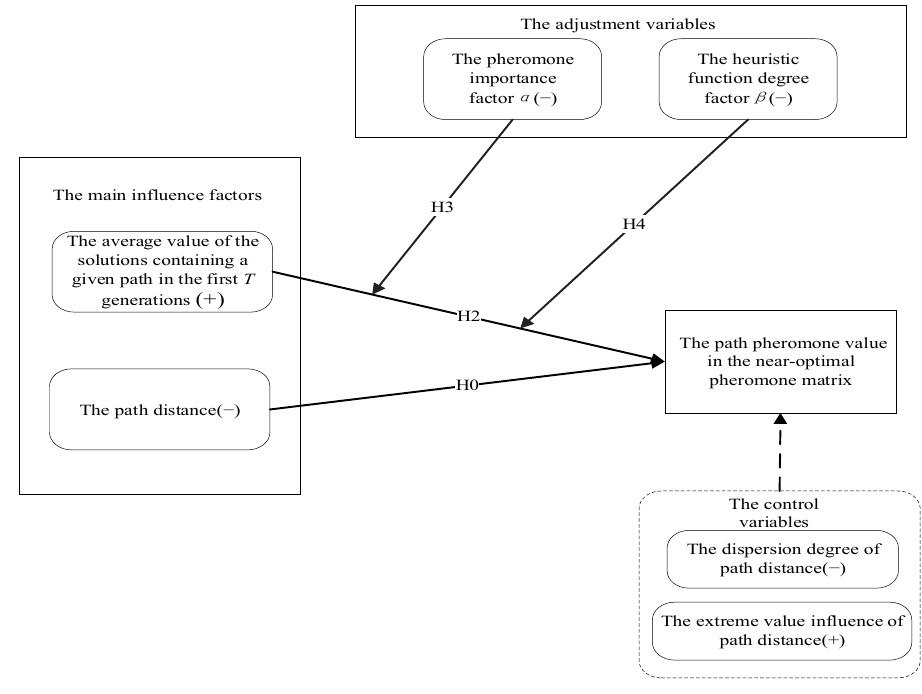
Figure 3. The results of the hypothesis test.